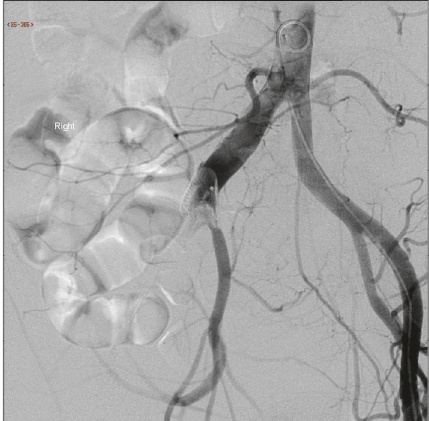
Figure 4: Digital subtraction angiography demonstrating distorted patent foramen ovale occlusion device in right common iliac